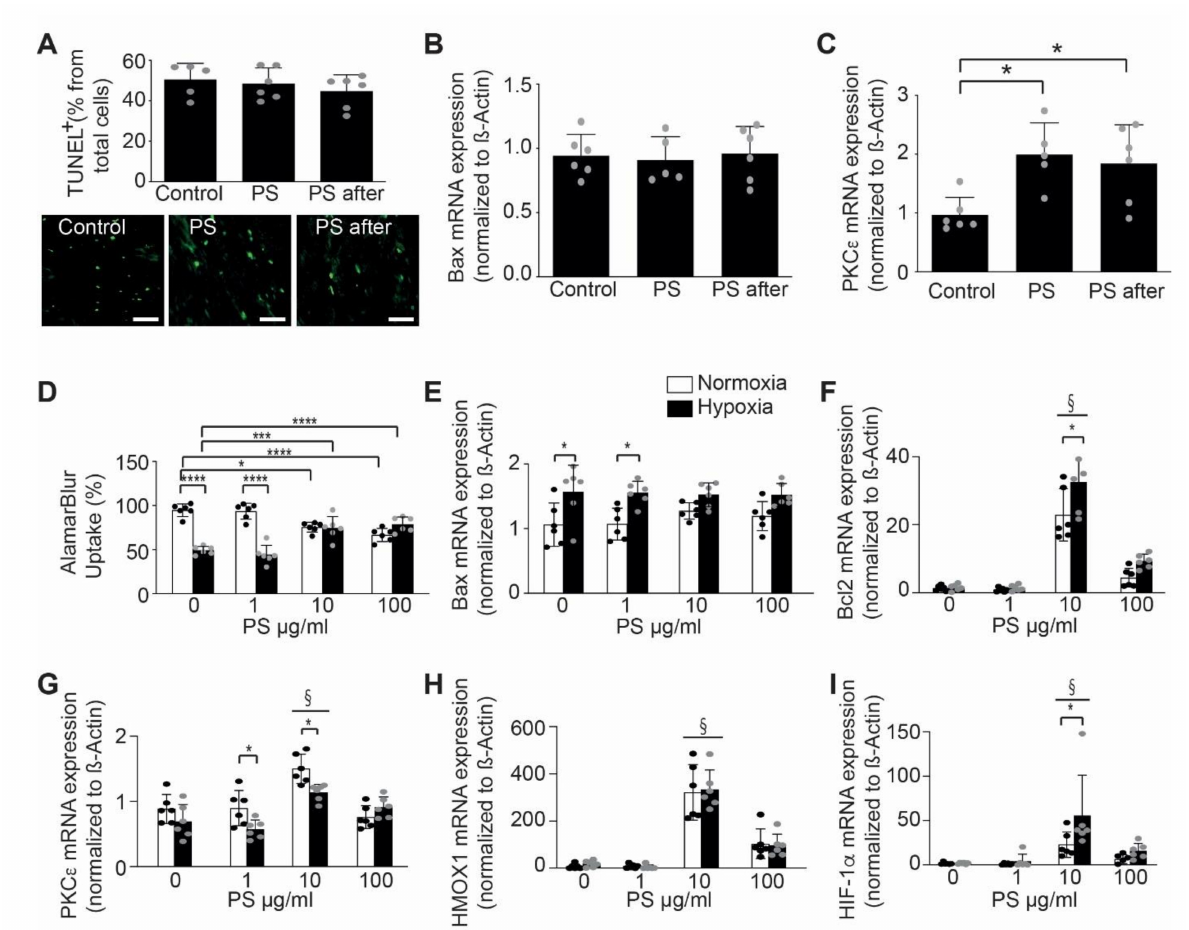
Figure 2. Phosphatidylserine oral supplementation effects on cardio-protection. ( A ) There was no difference in apoptotic cell death between the two groups measured by TUNEL staining of myocardial infarction in mice, untreated (Control), treated with phosphatidylserine before and after AMI (PS) or phosphatidylserine only after AMI (PS after, n = 5–6/group, One-way ANOVA, Tukey’s multiple comparison Test, * p < 0.05, Values ± SD). Lower panel shows representative images of